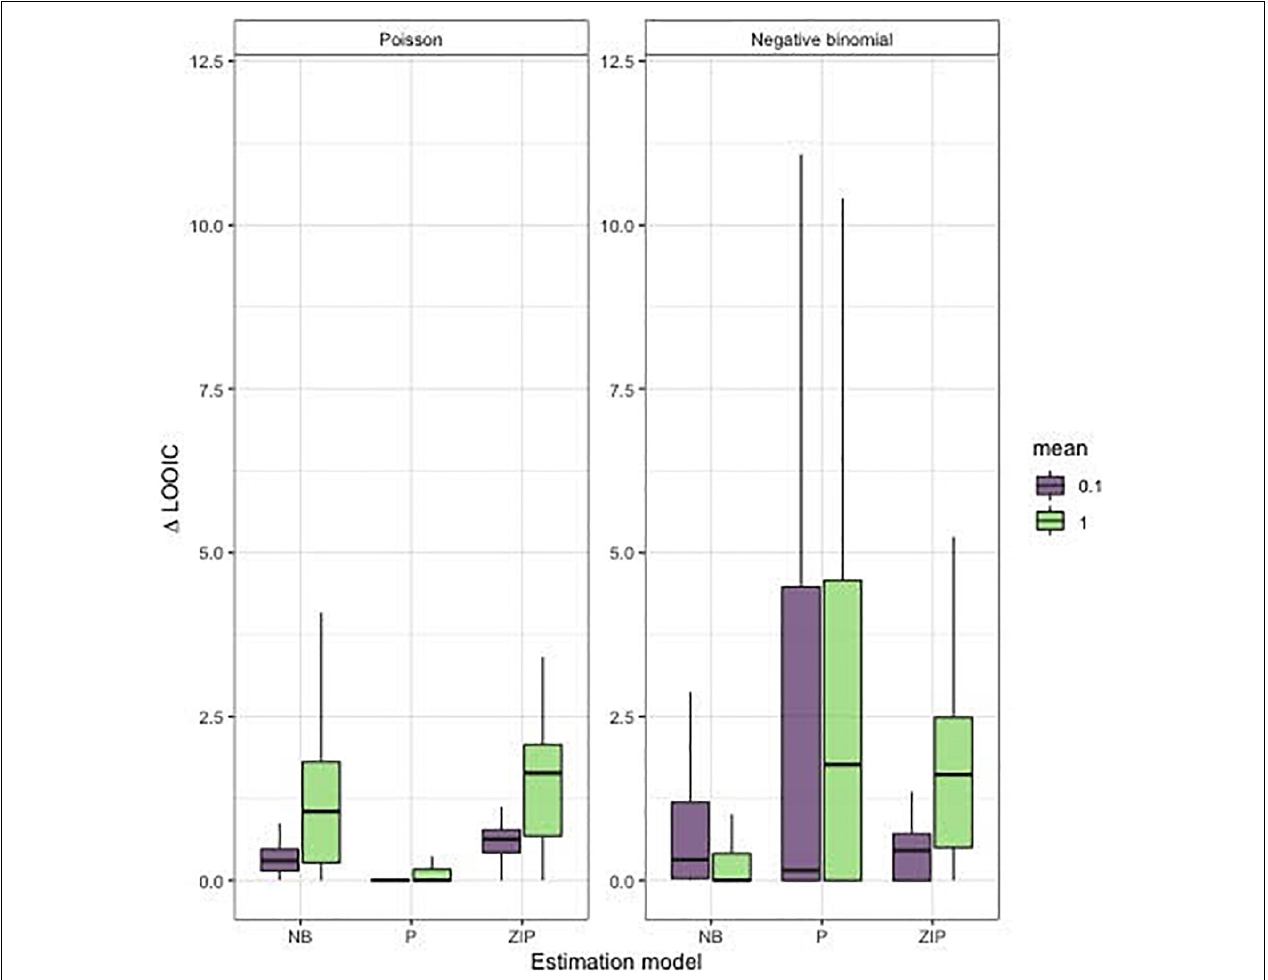
FIGURE 3 | Distribution of LOOIC differences for our model selection applied to simulated time series. Each boxplot represents 100 time series generated from each level of the mean bycatch rate (0.1, 1), estimation model (“NB,” negative binomial; “P,” Poisson; “ZIP,” zero-inflated Poisson), and simulation model (Poisson, negative